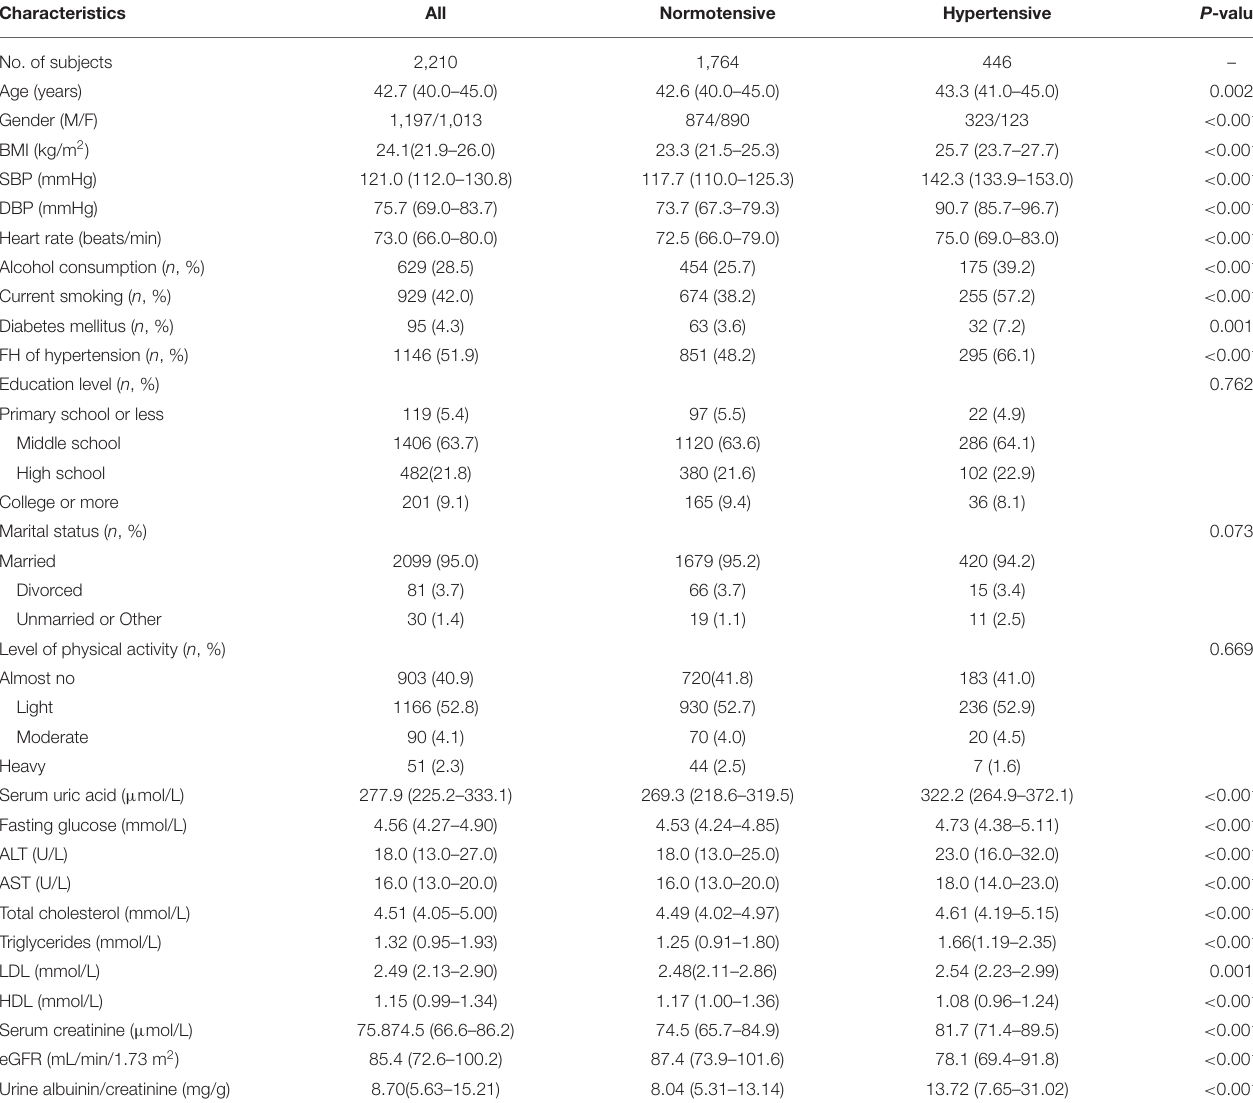
TABLE 4 | Characteristics of participants categorized by BP status in the cross-sectional cohort study ( n = 2,210).